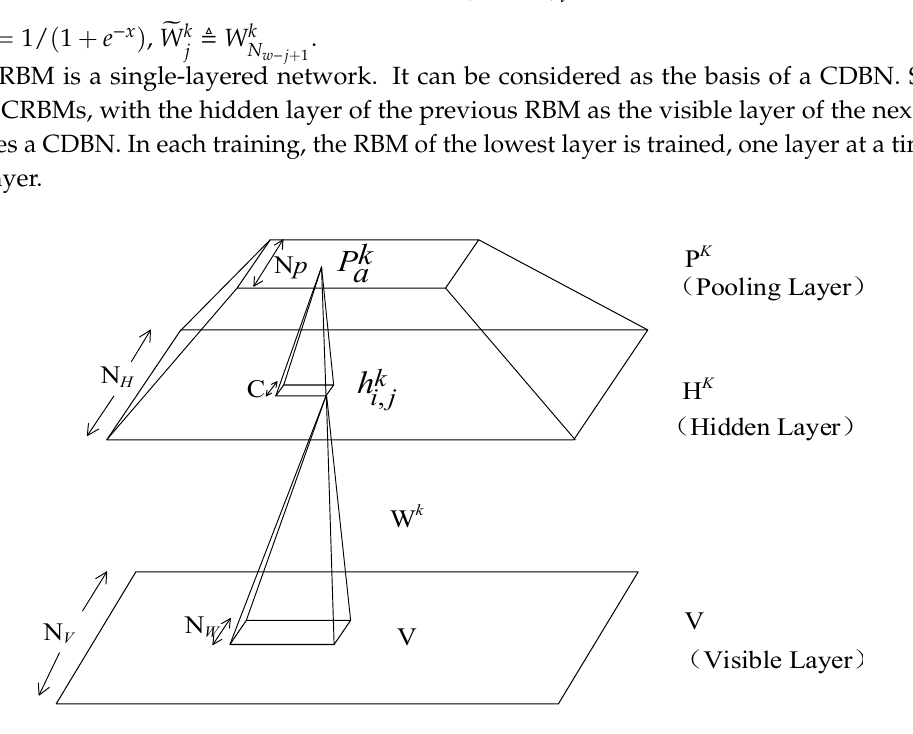
Figure 2. Structure diagram of a convolutional restricted Boltzmann machine (CRBM).